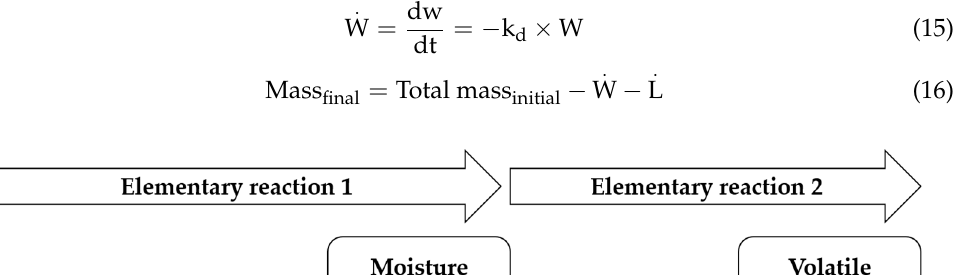
Table 1. Raw sample properties of Grape and Perilla.